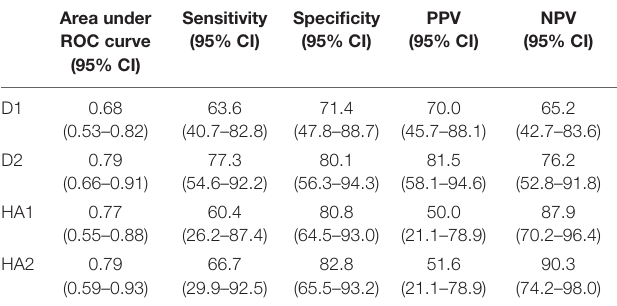
TABLE 4 | Diagnostic performance of model D (need to deliver within 7 days of diagnosis) and model HA (occurrence of HELLP syndrome or abruptio placentae ) in their basic (D1, HA1) and advanced (D2, HA2)